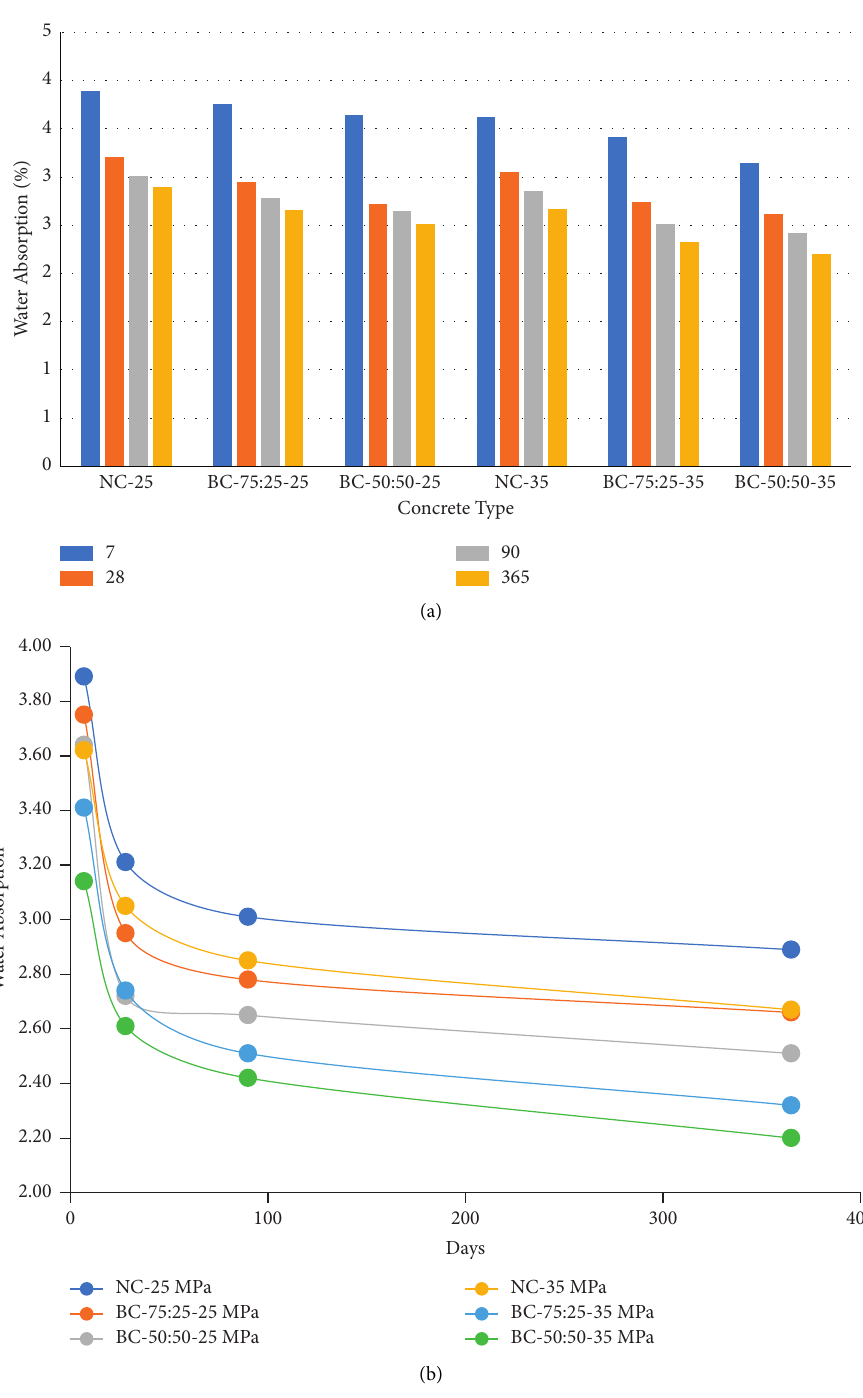
Figure 7: Variation of water absorption test results for various curing periods for 25MPa concrete and 35MPa